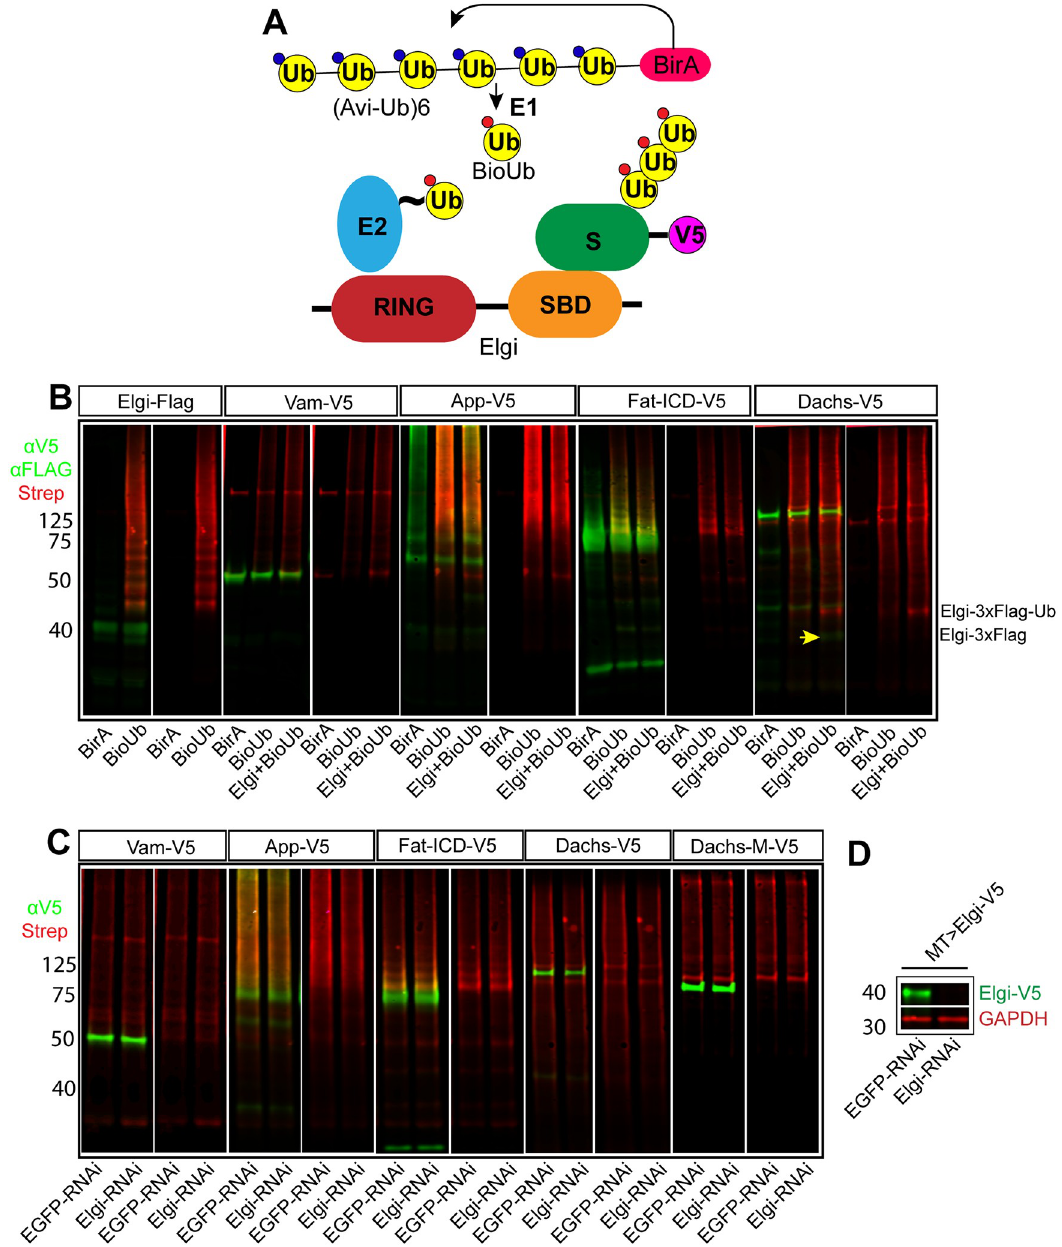
Fig 5. elgi does not ubiquitinate Vam, App, Fat-ICD or Dachs. (A) Schematic illustrating the ubiquitination assay used. BirA covalently conjugates Biotin to the fused Avi-tagged ubiquitin, which is processed by the E1 to produce biotinylated ubiquitin (BioUb), which is subsequently incorporated by the ubiquitination machinery onto the substrates. This can be detected by fluorescently conjugated streptavidin. (B) Western blot showing results of ubiquitination experiments on proteins expressed in S2 cells. For Elgi autoubiquitination, 3xFLAG tagged Elgi was co-expressed with either BirA or BirA-BioUb and immunoprecipitated using anti-Flag beads. Elgi was detected by anti-FLAG antibody. V5-tagged Full length Vam (Vam-V5), App (App-V5), Fat-ICD (Fat-ICD-V5) or Dachs (Dachs-V5) were co-expressed with either BirA alone or BirA-BioUb with or without Elgi-3xFLAG. V5-tagged proteins were immunoprecipitated from cell lysates, and detected with anti-V5 antibody. In all lanes, biotinylated Ubiquitin was detected with IRDYE680 conjugated streptavidin (Red). The yellow arrow points to a faint band of Elgi-3x-FLAG immunoprecipitated with Dachs:V5; the strong red band just above it is ubiquitinated Elgi-3x-FLAG, based on size and detection with anti-FLAG antibodies. Its appearance presumably reflects the strong association of Elgi with Dachs. (C) Western blot showing results of ubiquitination experiments on proteins expressed in S2 cells treated with dsRNA against either EGFP (control) or elgi . V5-tagged Full length Vam (Vam-V5), App (App-V5), Fat-ICD (Fat-ICD-V5), full length Dachs (Dachs-V5) or middle domain